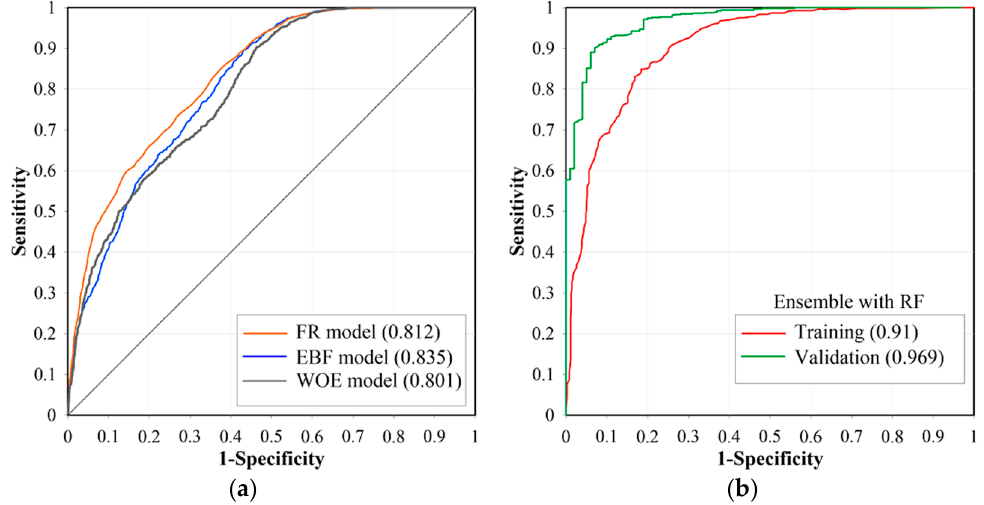
Figure 13. Validation using a receiver operating characteristic curve (ROC). ( a ) Success rate curves of bivariate models (FR, EBF and WOE) using training data; ( b ) success rate and prediction rate of the ensemble RF landslide susceptibility model.